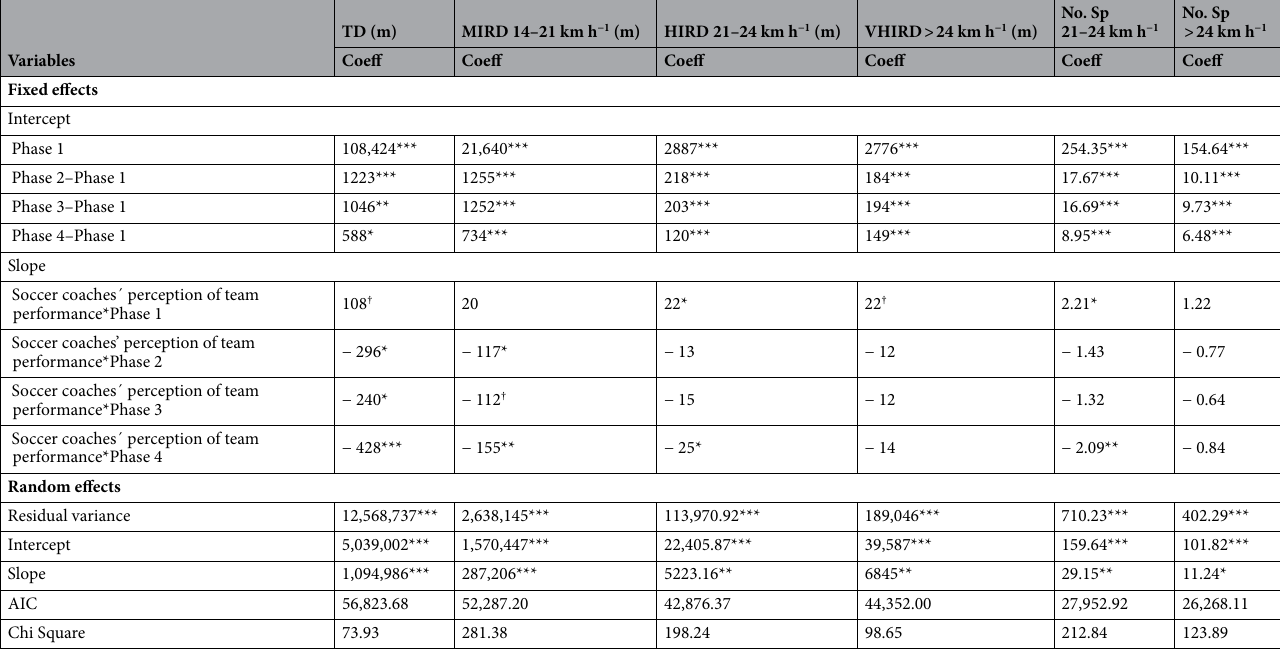
Table 3. Linear mixed model results of match movement profiles by team performance and season phases for Spanish soccer teams. m meters, No. number, TD total distance, MIRD medium-intensity running distance, HIRD high-intensity running distance, VHIRD very high-intensity running distance, Sp21-24 Sprints between 21 and 24 km h −1 , Sp > 24 = Sprints at speeds above 24 km h −1 , Coeff. Coefficient. † p < 0.07, * p < 0.05, ** p < 0.01, *** p < 0.001.